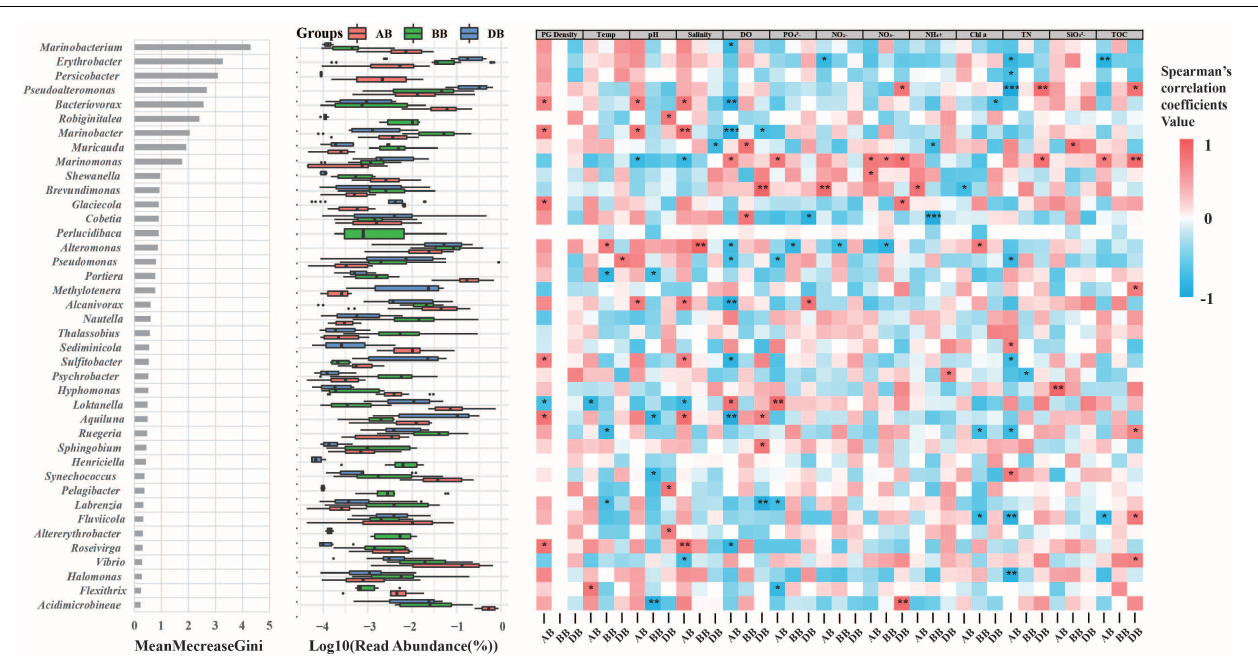
FIGURE 5 | Top 40 most important genera for random forest classification. Left, the top 40 taxa were assessed by the Gini index, which indicated the importance of each genus in distinguishing various groups; middle, read abundances of the top 40 genera; right, the Spearman’s correlations between the relative abundances of the top 40 genera and the environmental parameters. PG density, P. globosa density; Temp, temperature; DO, dissolved oxygen; TN, total nitrogen; TOC, total organic carbon; BB, before P. globosa blooms; DB, during P. globosa blooms; AB, after P. globosa blooms. * p < 0.05, ** p < 0.01, *** p < 0.001.